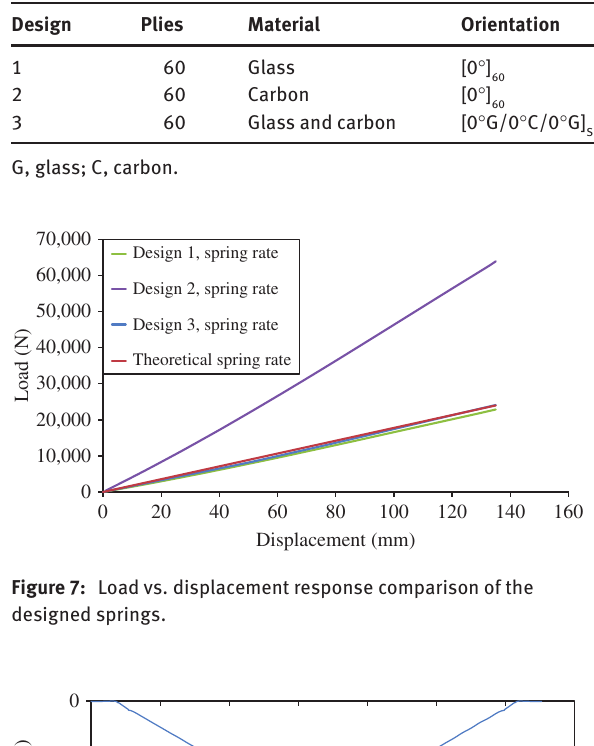
Table 6: Configurations of composite-based leaf spring systems created.